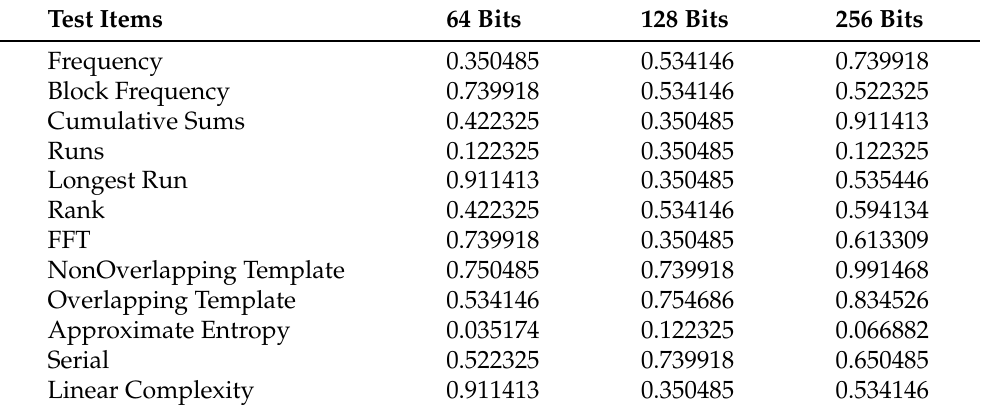
Table 5. NIST randomness test.